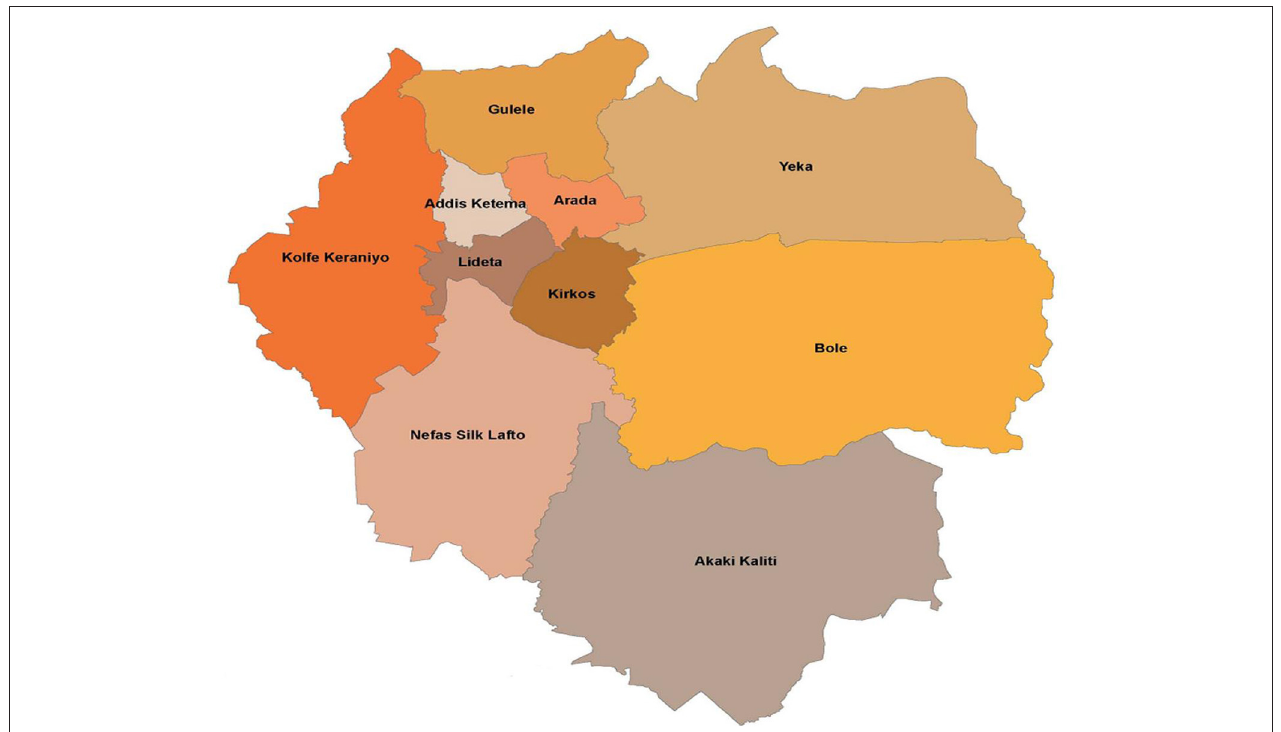
FIGURE 1 | Sub-cities in Addis Ababa included in the study